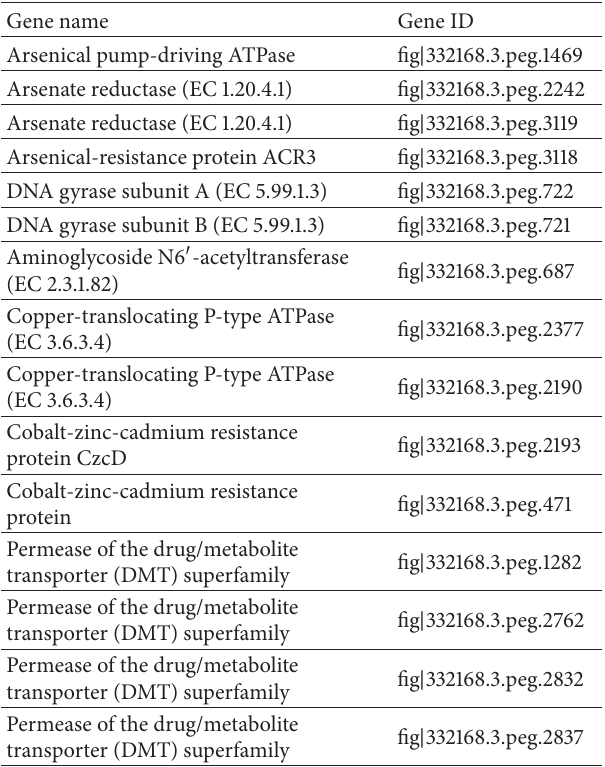
Table 3: Putative genes coding for heavy metal resistance in H. hamelinensis .